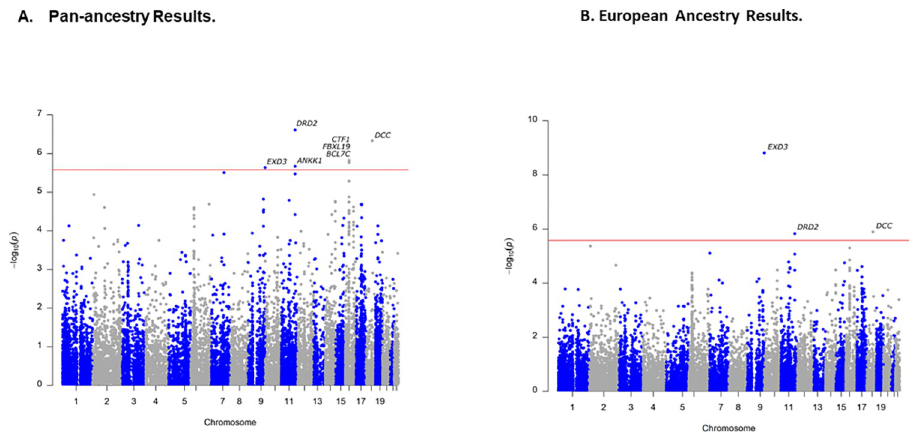
Fig 2. Gene-based Manhattan Plots. A. Pan-ancestry Results. B. European Ancestry Results.